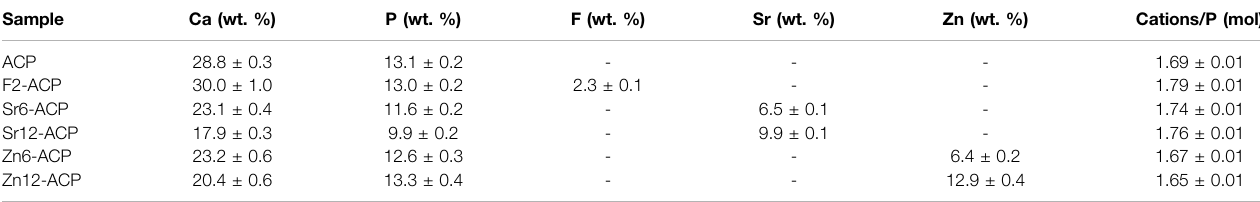
TABLE 1 | Chemical composition of the ion-doped ACP materials. Sample Ca (wt.